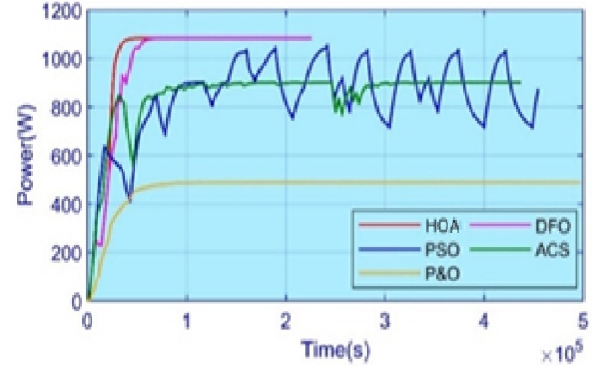
Figure 22. Comparison of the HOA power for Case 4 .